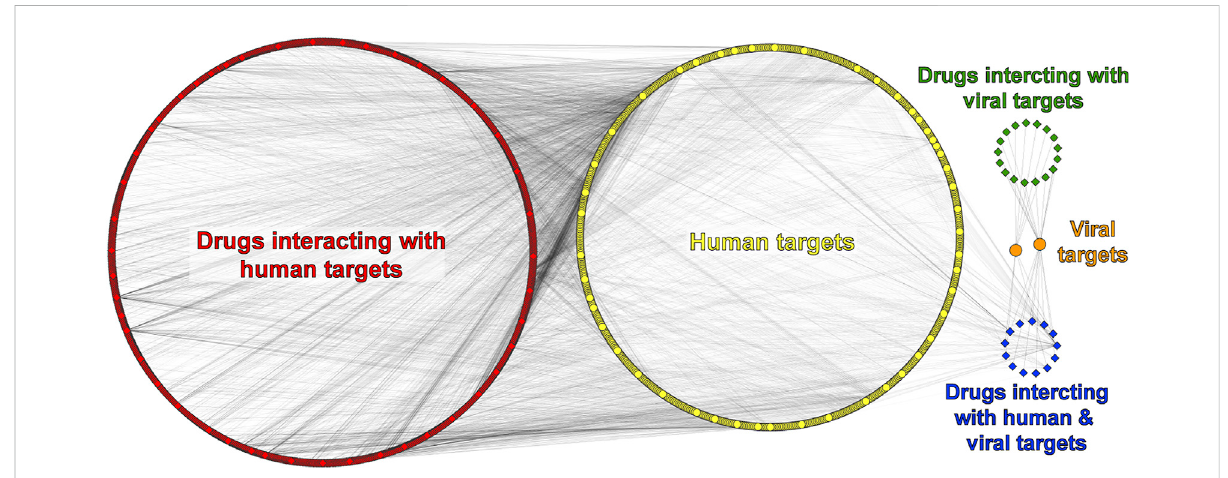
FIGURE 2 Drug – protein interaction (DPI) network. Human/viral proteins and drugs are shown as circles and diamonds,